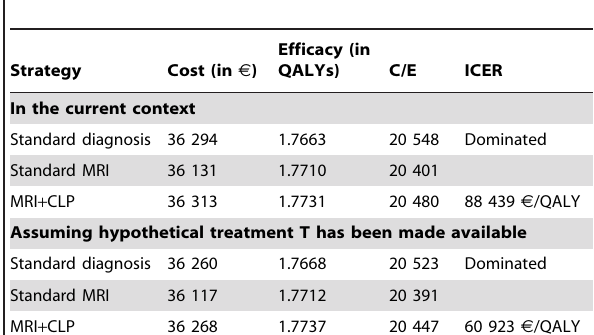
Table 2. Results of the primary analysis (base-case hypothesis): computed cost, efficacy and cost-effectiveness (C/E) ratio of the standard diagnosis, standard MRI and MRI + CLP strategies, and incremental cost-effectiveness ratios (ICER) of the MRI + CLP strategy as compared with the standard MRI